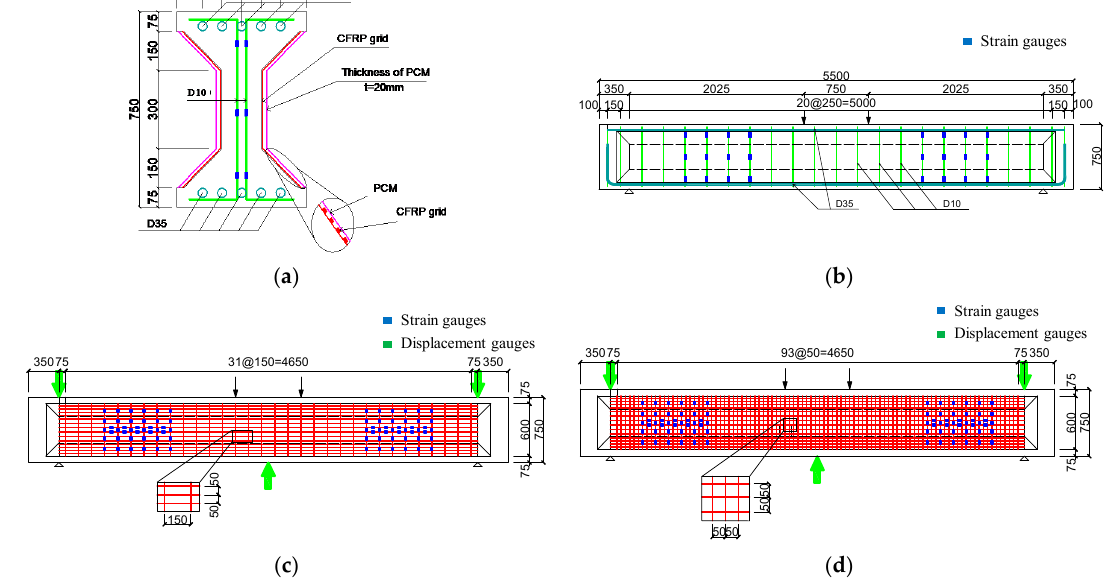
Figure 8. Schematic of specimens in Series B (Unit: mm): ( a ) Side view for strengthened beams with FRP grid; ( b ) Front view for reinforcement cage and the longitudinal section of the beam; ( c ) Front view for FRP grid area (150 mm × 50 mm, i.e., RHWC4, RHWC6, RHWC8, RHWC64); ( d ) Front view for FRP grid area (50 mm × 50 mm, i.e., RHWC4 ′ ).